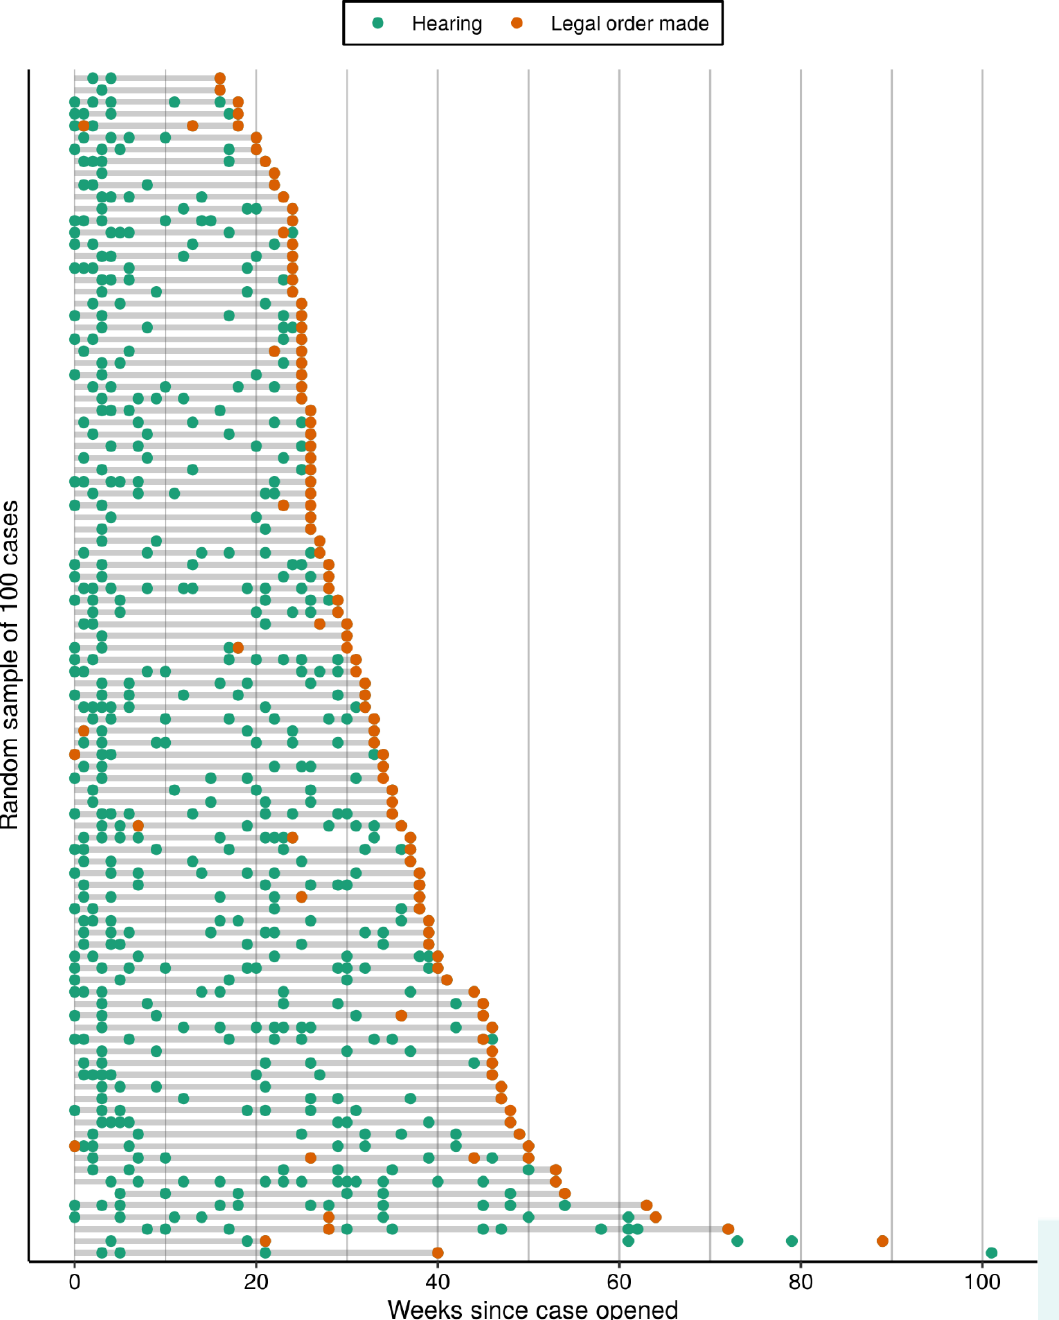
Figure 3: The timelines of a random sample of 100 public law cases based on the Cafcass data